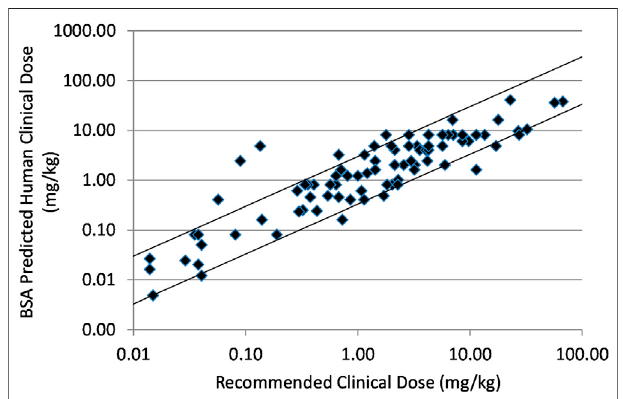
FIGURE 1 | Relationship between recommended clinical doses and clinical doses predicted from BSA scaling of mouse effective doses for ninety marketed small molecule, intravenous or oral oncology drugs. Solid lines indicate plus and minus 3-fold from precise prediction.